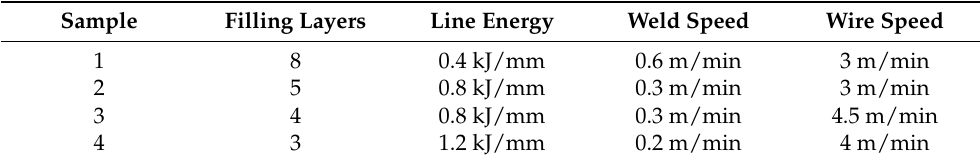
Table 2. Process parameters of multilayer swing laser wire filling welding.